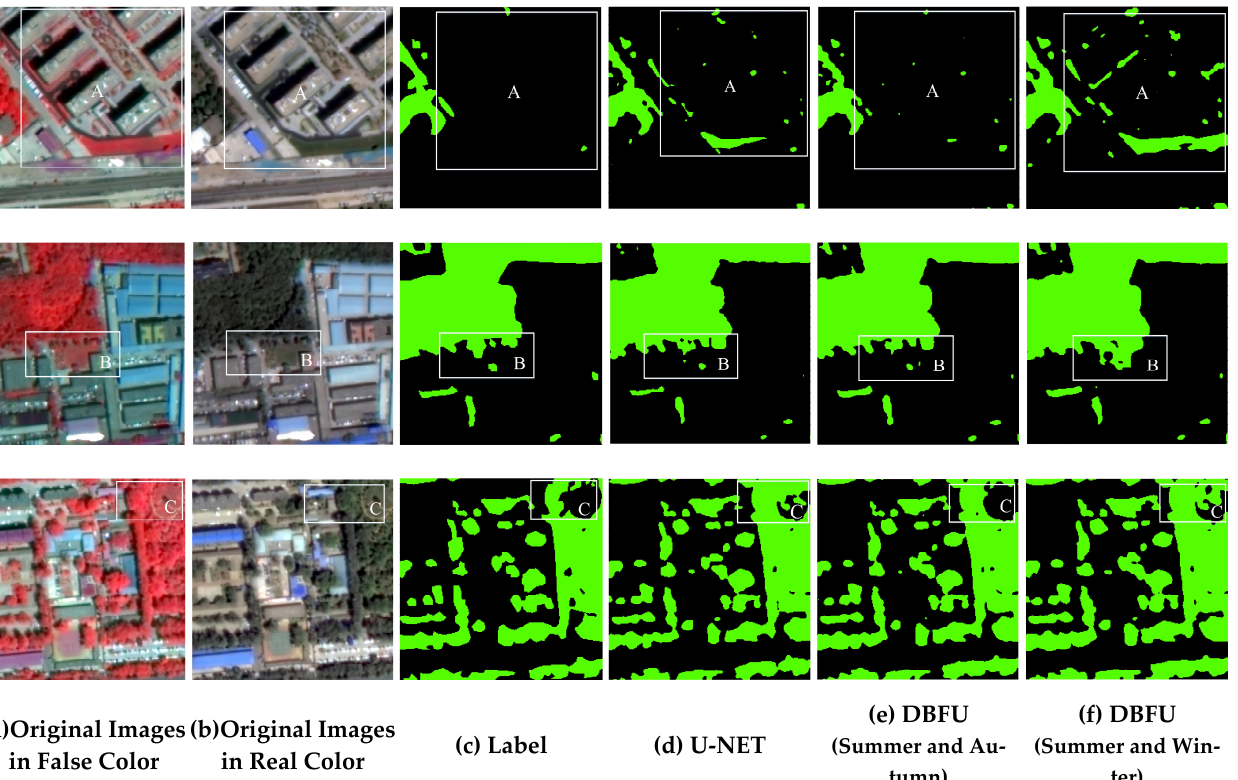
Figure 16. Comparison of classification results of different seasonal combinations of images: (a) original images in false color, (b) original images in real color, (c) ground truth, (d) classification results